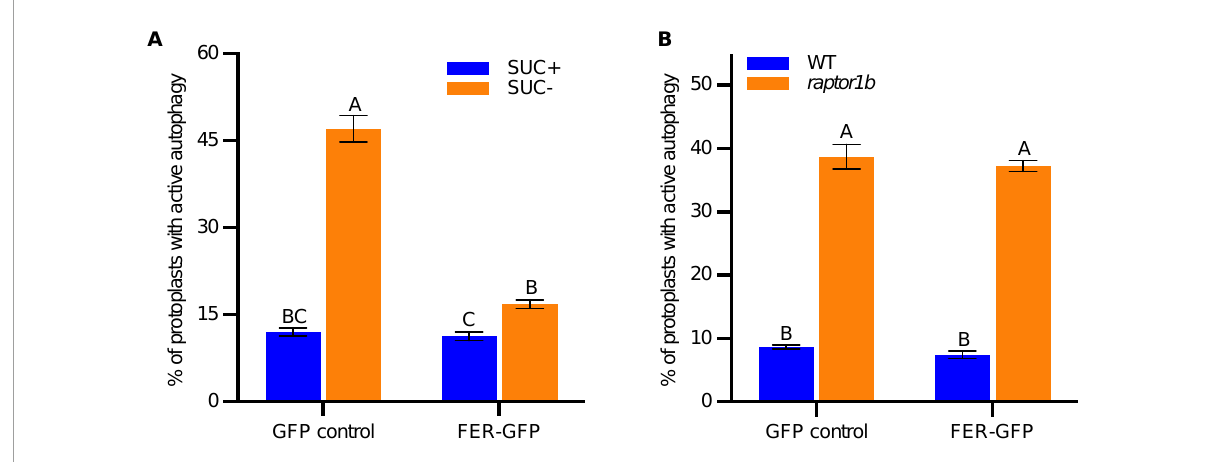
FIGURE5 FER-GFP inhibits sucrose starvation-induced autophagy but not the constitutive autophagy in raptor1b . (A,B) Quantification of protoplasts with ATG8e labeled autophagy. (A) GFP control or FER-GFP was co-expressed with mCherry-ATG8e in Col-0 protoplasts, treated without or with 0.5% (w/v) sucrose for 36 h before microscopy. B, GFP control or FER-GFP was co-expressed with mCherry-ATG8e in Col-0 and raptor1b protoplasts, followed by 20 h incubation before microscopy. Protoplasts with more than three visible autophagosomes were counted as being active for autophagy. A total of 100 well-expressed protoplasts were observed for each treatment per genotype, and the percentage of protoplasts with active autophagy was calculated. Data are shown as means ± SEM from 3-4 biological replicates. Different letters